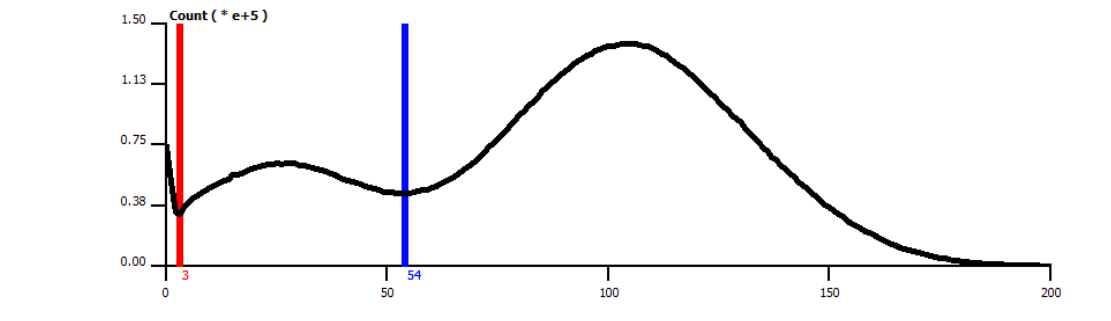
Figure 4. Intensity histogram (black line) of the cropped FIB dataset containing inhomogeneous lipid droplet; The red line shows the threshold for inhomogeneous inclusions; the blue line—the threshold of lipid